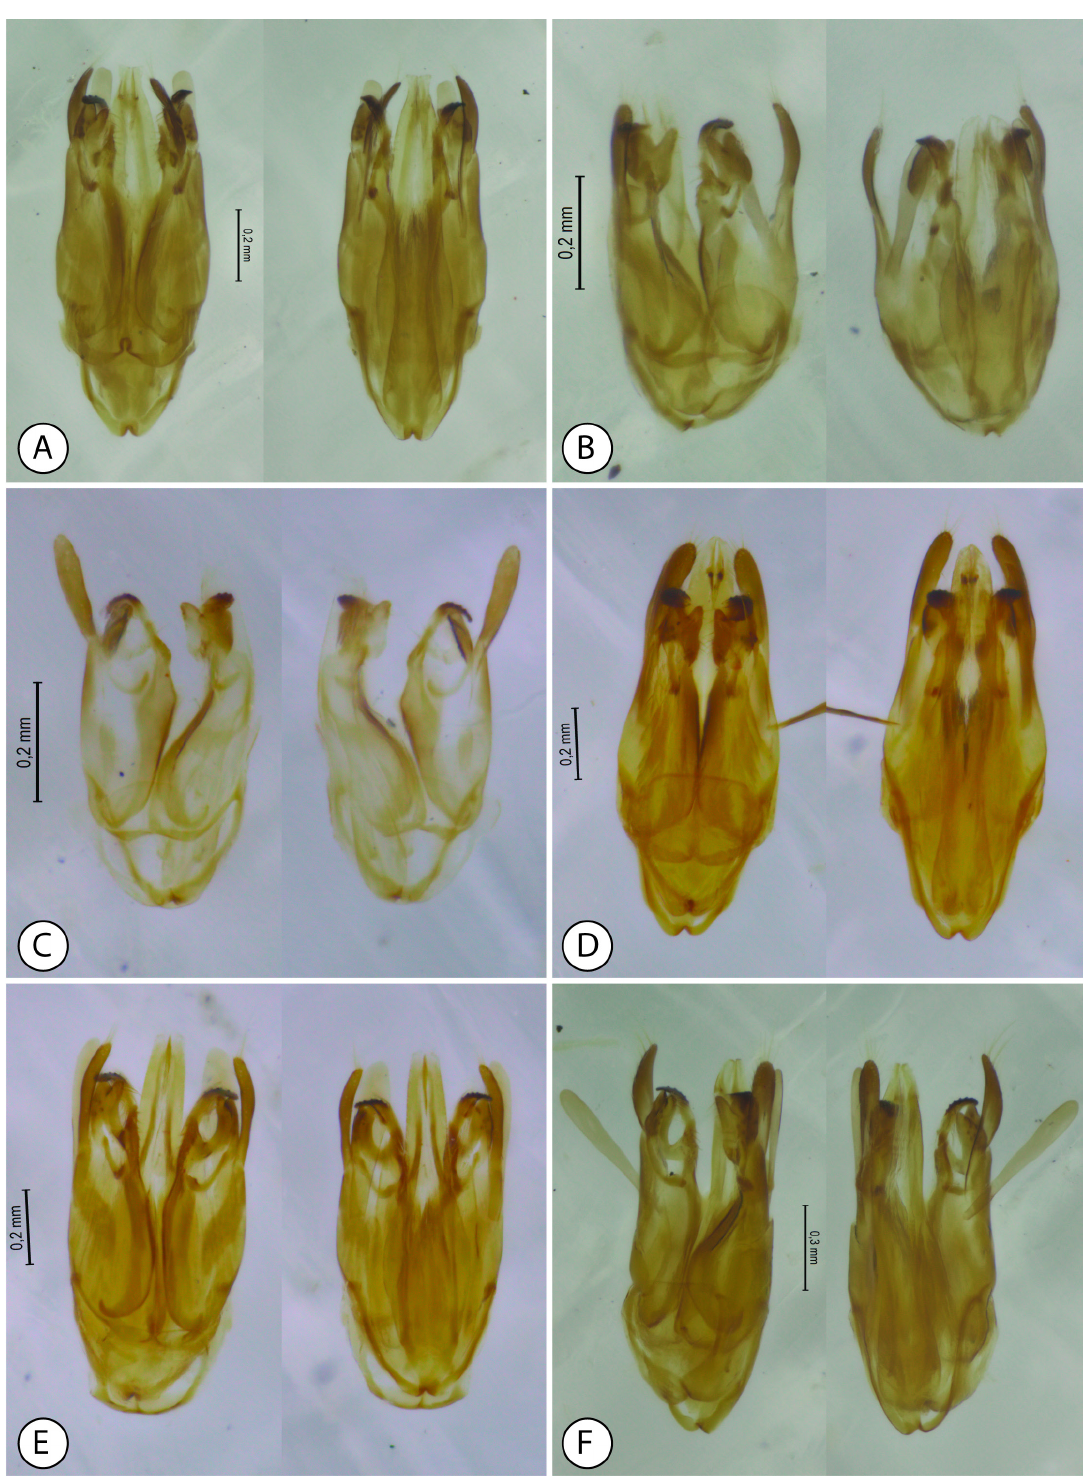
Fig. 3. Genitalia of Astromesitius gen. nov., left ventral and right dorsal view. A . A. olavoi gen. et sp. nov. (holotype, QBG) B . A. thionyi gen. et sp. nov. (holotype, UFES 118956) C . A. carbonarius (Móczár, 1970) gen. et comb. nov. (UFES 56168) D . A. indistintus (Barbosa & Azevedo, 2011) gen. et comb. nov. (paratype, UFES) E . A. minutissimus (Móczár, 1971) gen. et comb. nov. (holotype, UFES 56528) F . A. quatei (Móczár, 1977) gen. et comb. nov. (holotype,